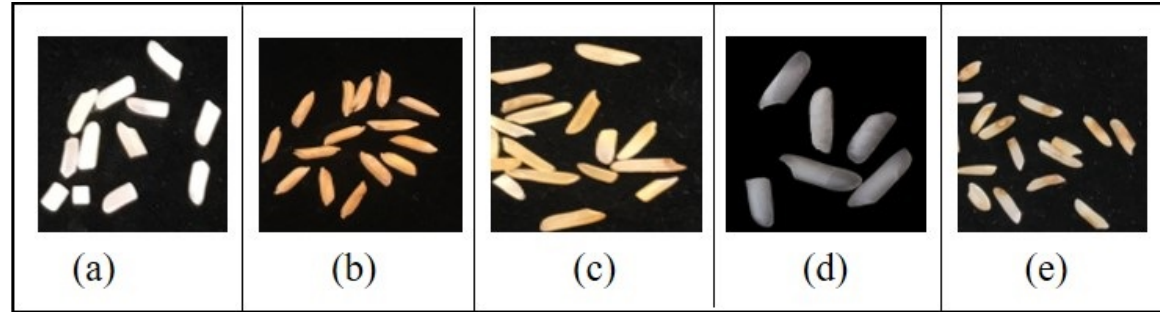
Figure 3. Visuals of ( a ) broken, ( b ) paddy, ( c ) yellow, ( d ) chalky, ( e ) damaged rice kernels.